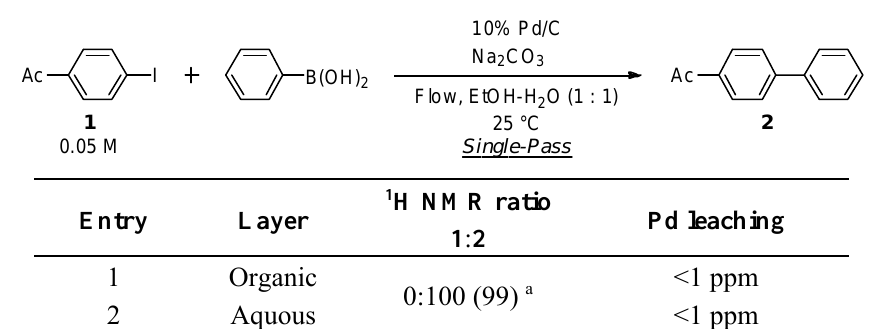
Table 3. Leaching test of the